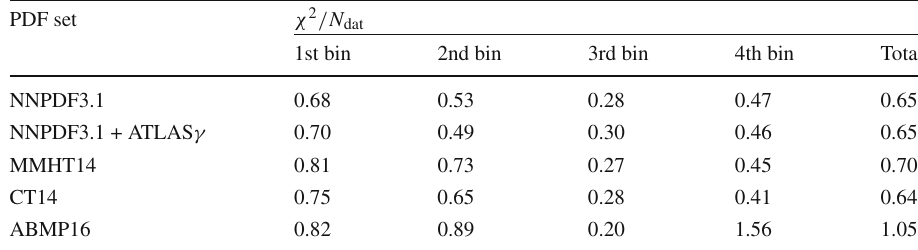
Table 7 Same as Table 1 for the ATLAS 13 TeV direct photon production